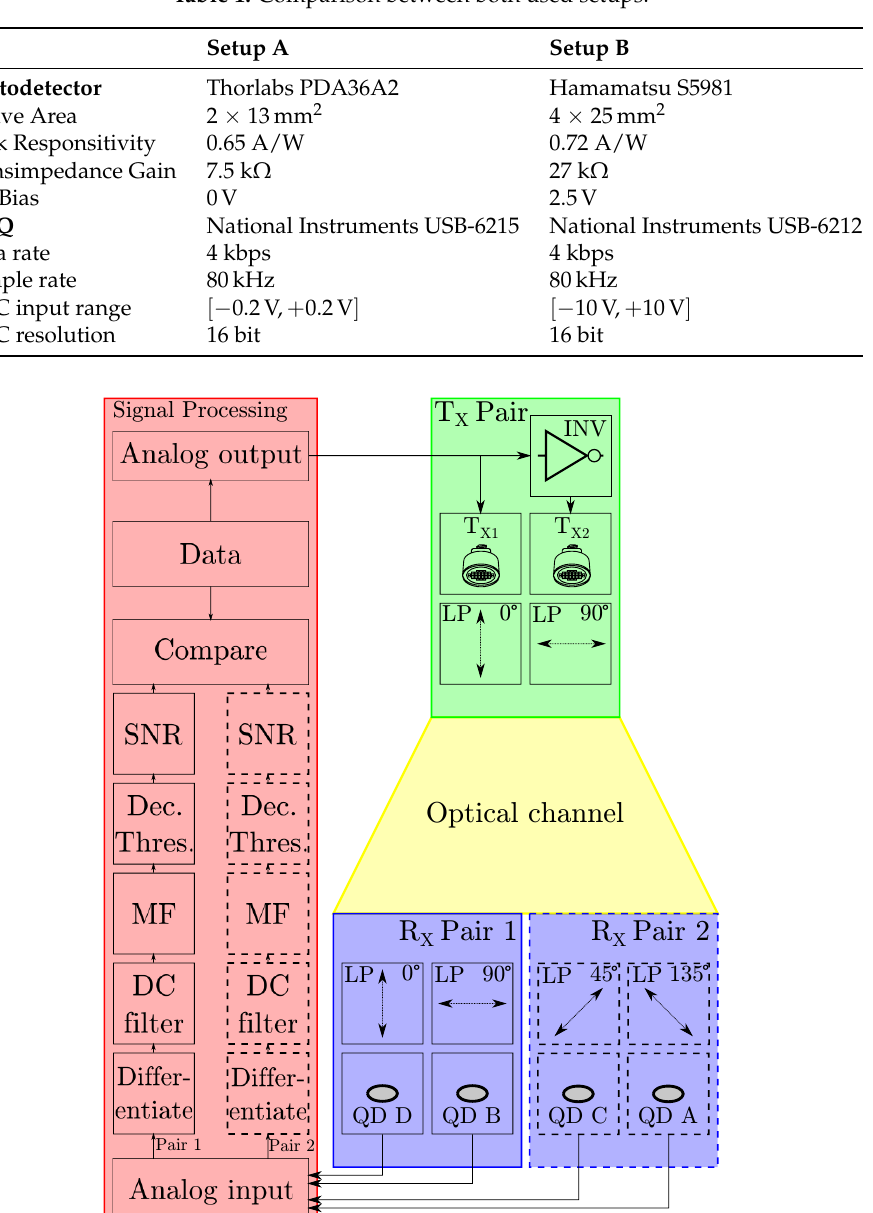
Table 1. Comparison between both used setups.